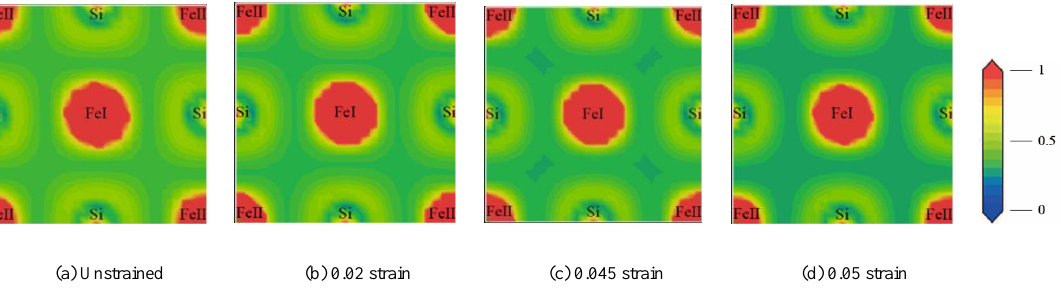
Figure 10. Valence electron density distribution in the (200) atomic planes of DO3 under triaxial tensile strains. ( a ) unstrained, ( b ) 0.02 strain, ( c ) 0.045 strain and ( d ) 0.05 strain. The deformation mode of this cubic structure was investigated. Figure 11 presents the valence electron density distribution in the (200) atomic planes of DO3 under triaxial compressive strain.